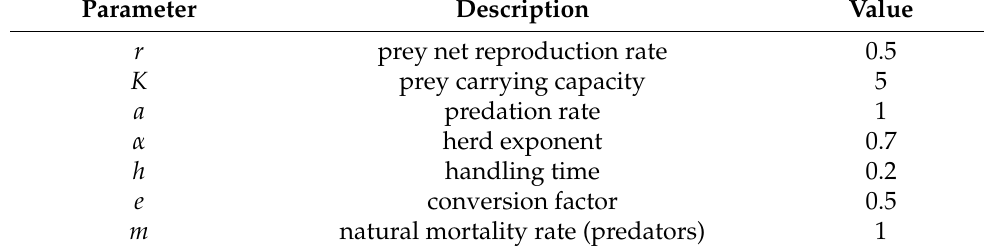
Table 8. Nominal set of parameter values for the model in (34) and (35).